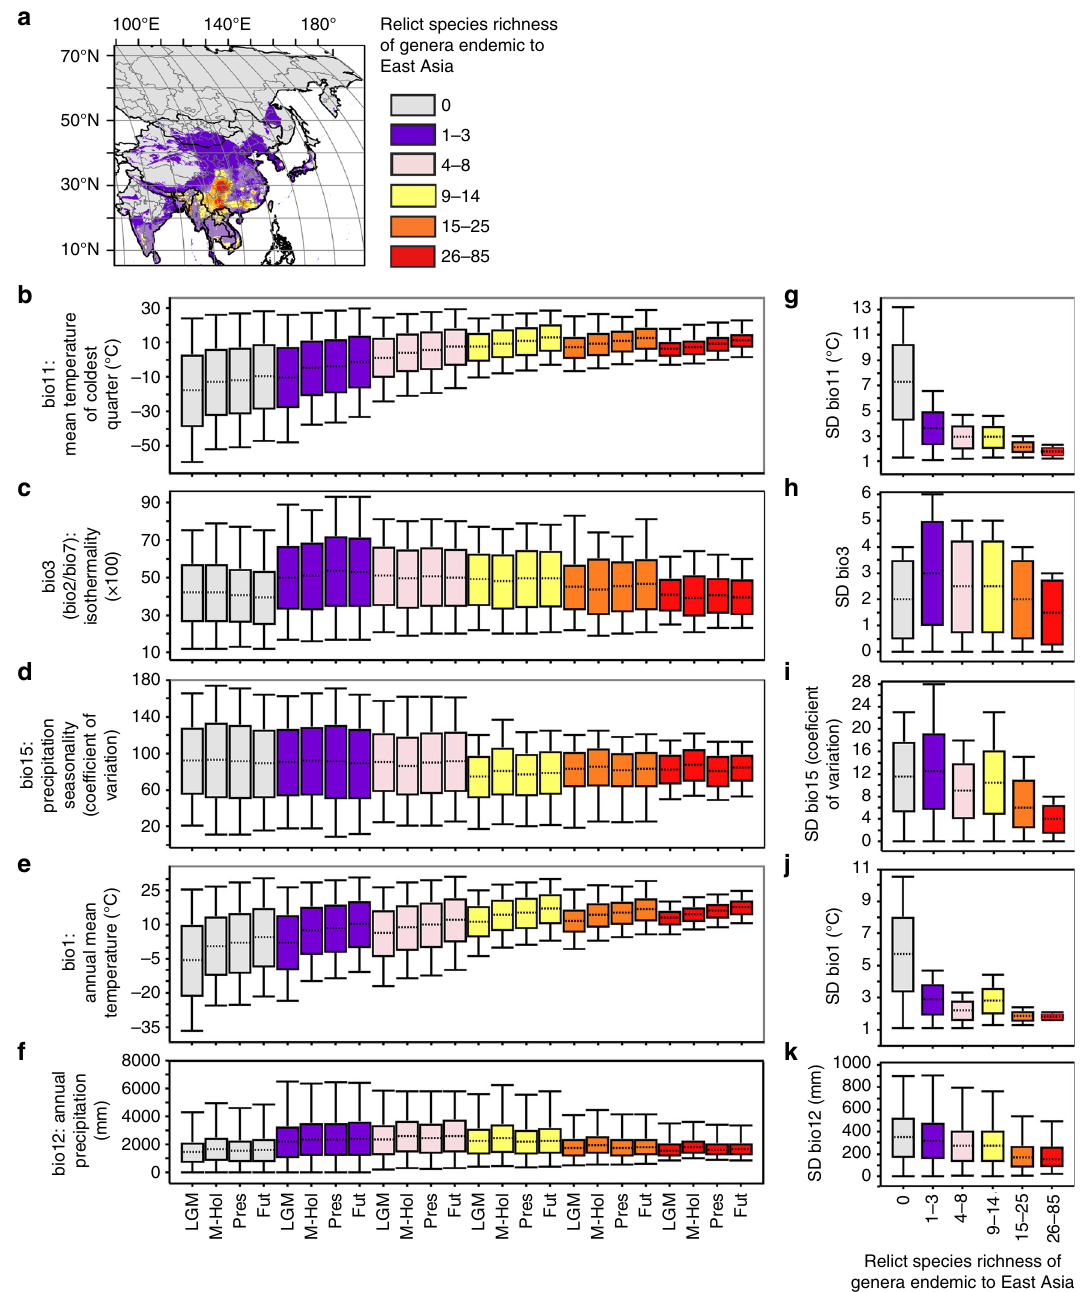
Fig. 6 Climatic variables in different categories of suitable areas of relict species. a Long-term stable refugia (red areas) of relict species of genera endemic to East Asia under scenarios Present-Past-Future RCP 2.6. Maps were generated using the software ArcGIS v. 10.5 (ESRI, Redlands, CA, USA) and modi fi ed using Canvas 12 (ACD Systems of America, Inc., Seattle, WA, USA). Map layers were obtained from site www.gadm.org. b – f Five climatic variables in different categories of suitable areas of relict species of genera endemic to East Asia in four time frames. g – k Value range of the standard deviation (SD) of each climatic variable in different categories of suitable areas. LGM, Last glacial maximum; M-Hol, Mid-Holocene; Pres, Present; Fut, Future (2070). b – k Boxplot representation: center line (median), upper end line whisker (maximum value), upper box bound (75th percentile), lower box bound (25th percentile), lower end line whisker (minimum